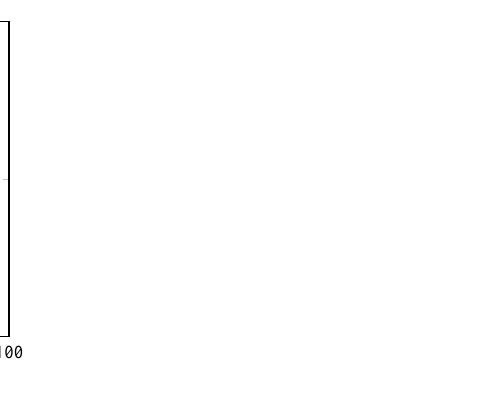
Figure 23. Load–displacement skeleton curves for models with different RCFSTK steel tube wall Figure 23. Load – displacement skeleton curves for models with different RCFSTK steel tube wall thickness. thickness .